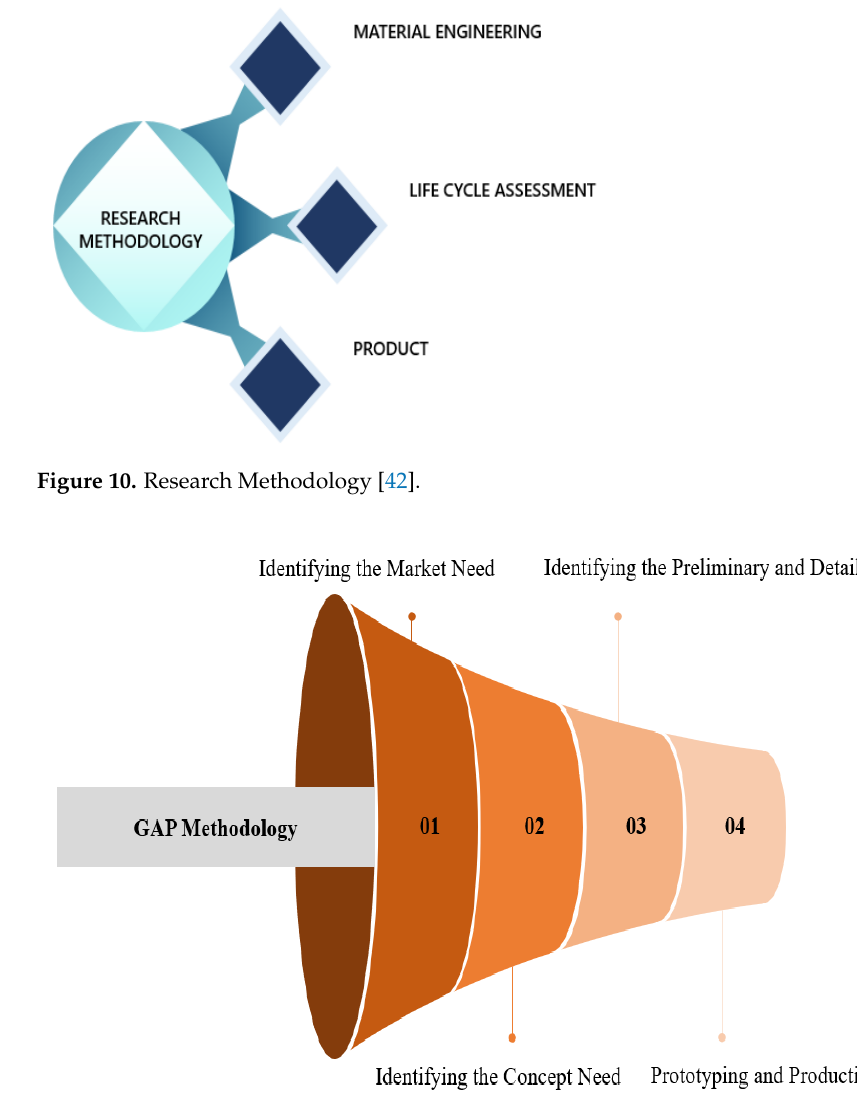
Figure 11. GAP Methodology [44]